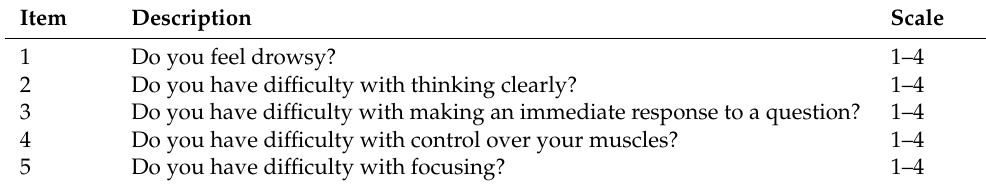
Table 1. The self-report assessment of